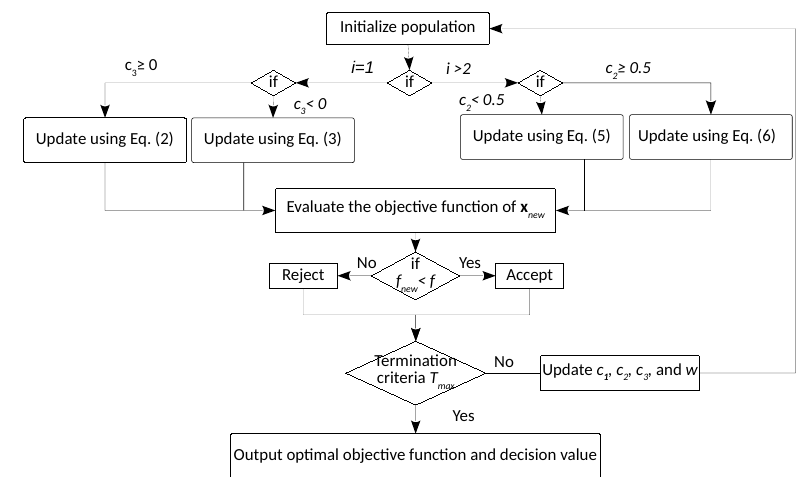
Figure 4. Block diagram of the